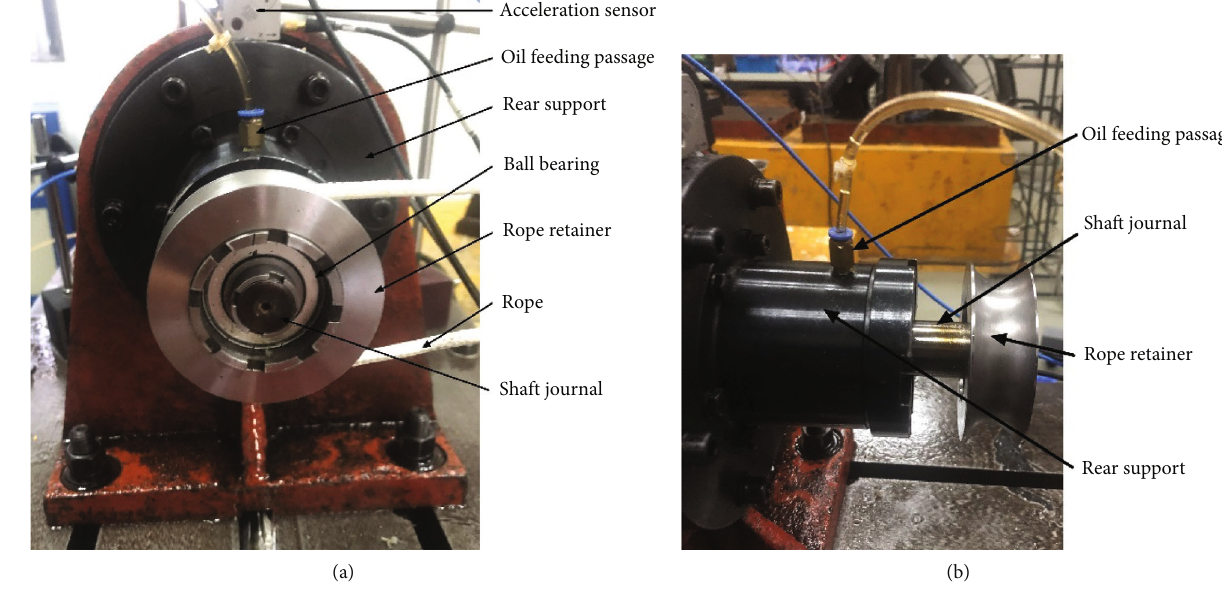
Figure 12: Rope retainer. (a) Main view. (b) Side view.